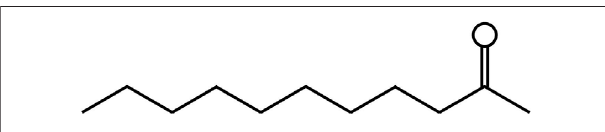
FIGURE 1 | Chemical structure of